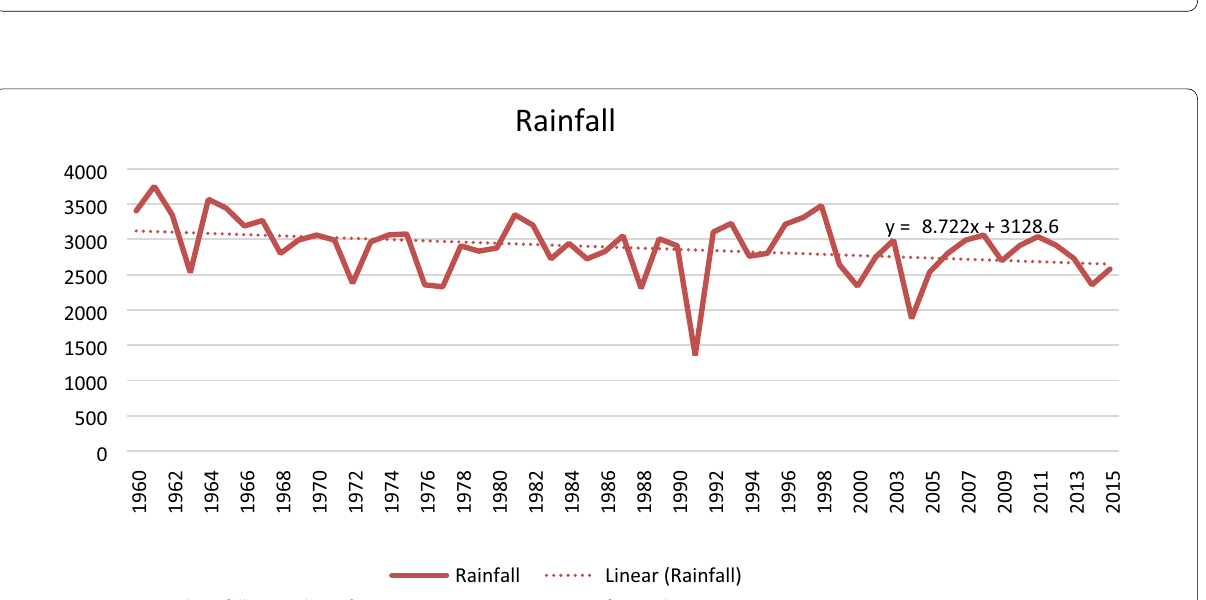
Fig. 6 Average annual rainfall around BFR from 1960 to 2015 ( Source: Manfe Weather Station